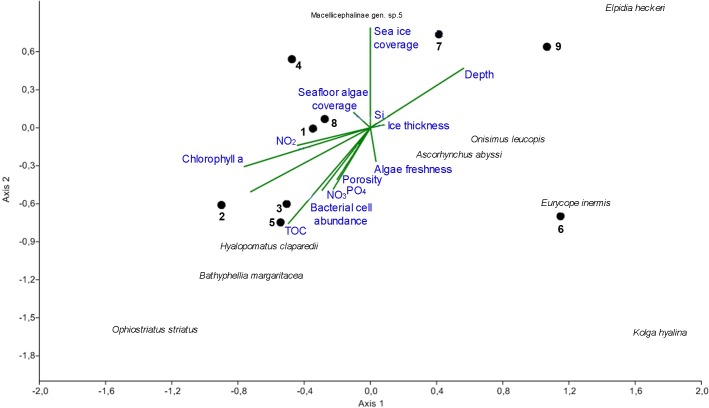
Canonical correspondence analysis (CCA).Explained variance on the first axis—41% and second axis—33%.